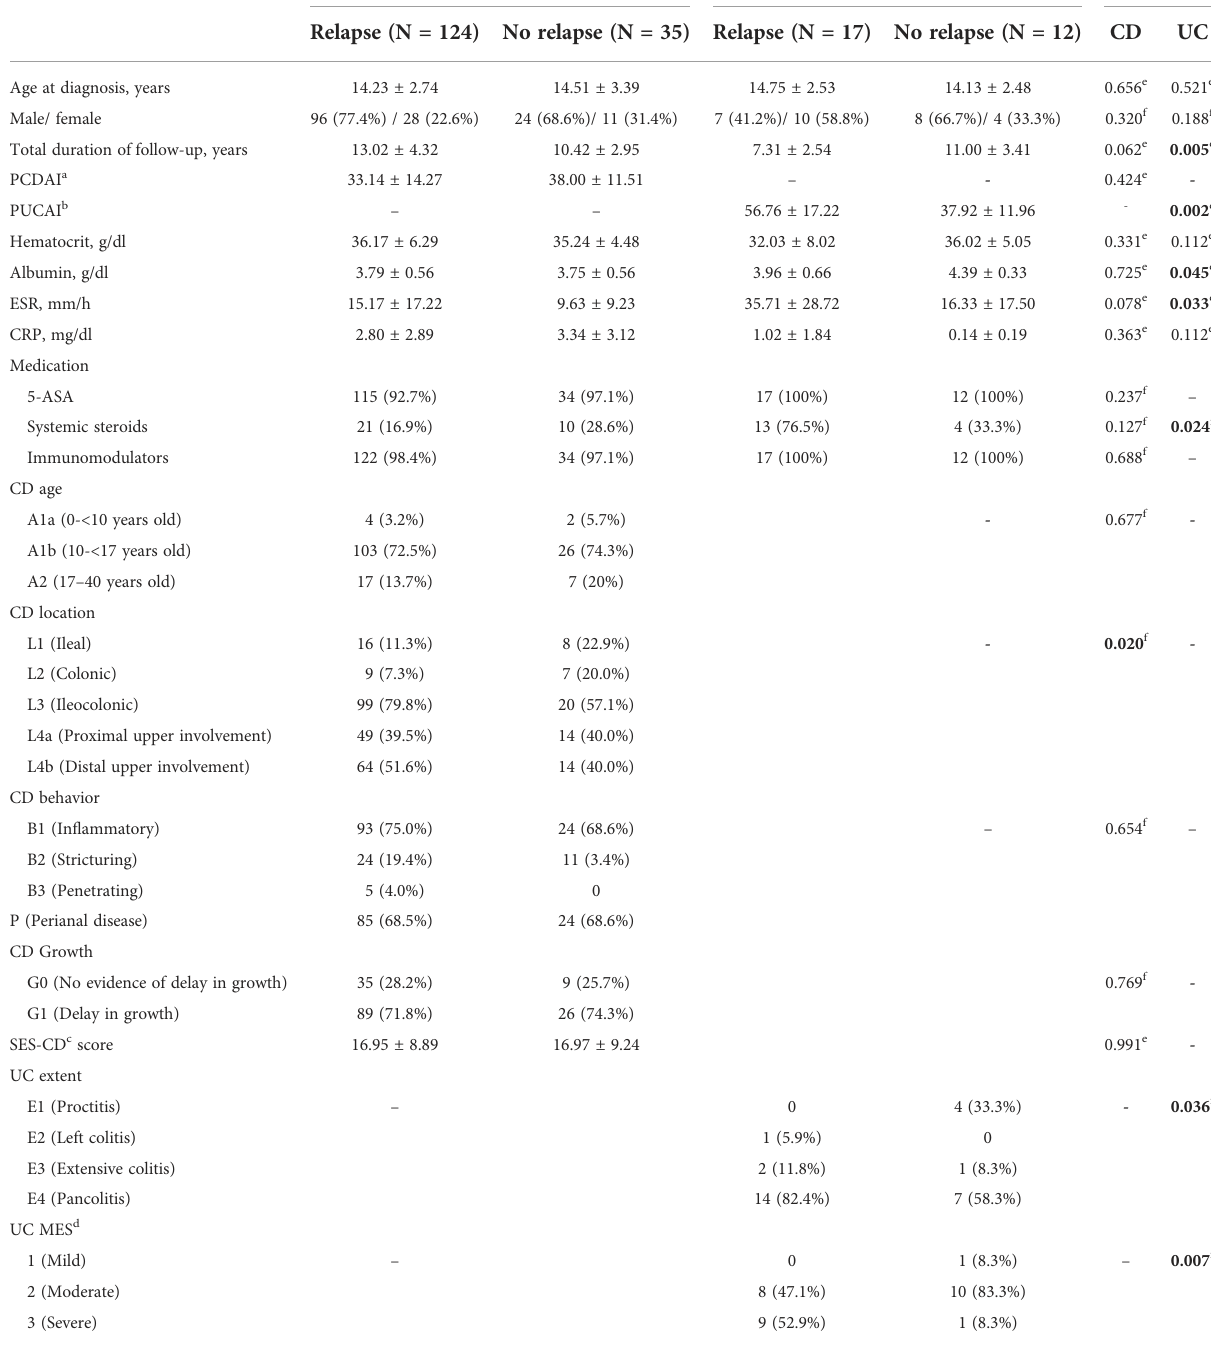
TABLE 1 Demographic and clinical features at diagnosis of the two experimental groups: patients who experienced relapse and patients who did not experience relapse after biologic